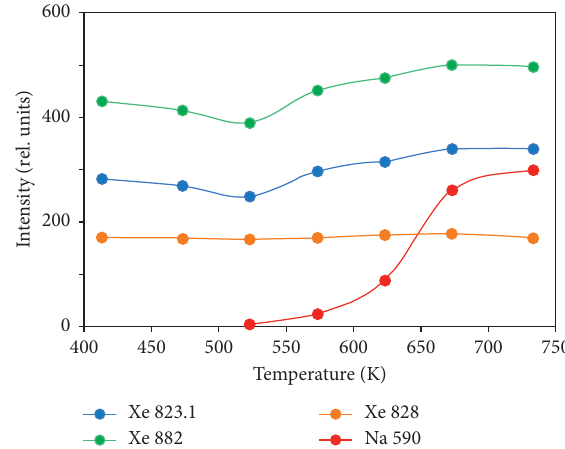
Figure 4: Dependence of intensity of xenon and sodium lines in the Kr-Xe mixture on the temperature of the lithium layer, F � 10 14 n/ cm 2 s.